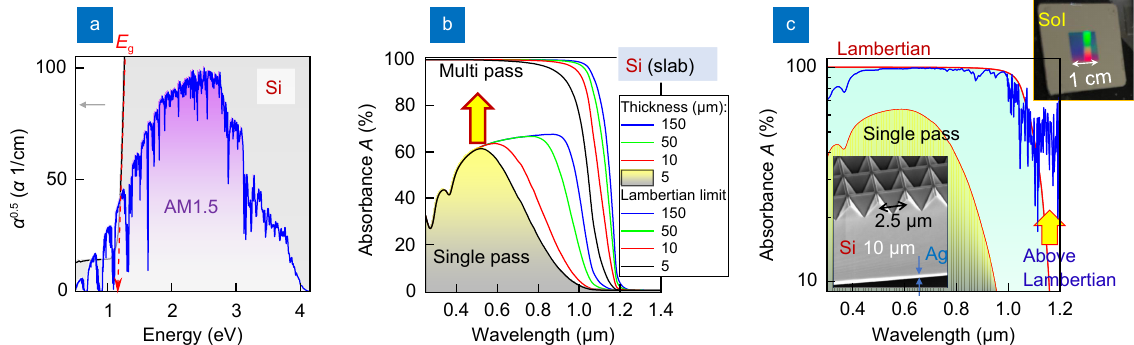
Fig. 1 | Why Si solar cells? ( a ) Absorption coefficient α of Si vs. photon energy (black line, grey shading) and solar spectrum profile (blue line, purple shading) at air mass AM1.5 ground conditions 10 . The arrow points to the bandgap energy E g . ( b ) Calculated absorbance for a Si slab with different thickness in single and multiple (the Lambertian limt) passes. ( c ) Absorbance of 10-μm-thick Si (device layer of SOI): single pass, Lam- bertian limit, and calculated PhC light trapping for the used geometry 6 . Inset shows the PhC structure made on a Si-on-insulator (SOI) substrate which exceed the ray optics Lambertian limit 6